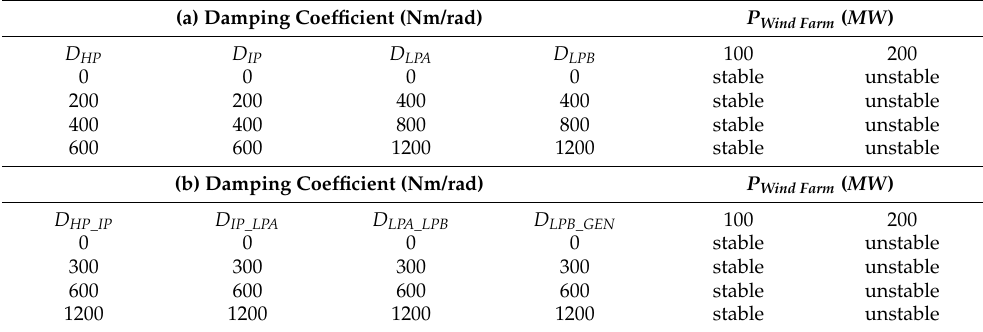
Table 5. ( a ) Stability under various turbine mass damping conditions ( b ) Stability for different turbine shaft damping levels